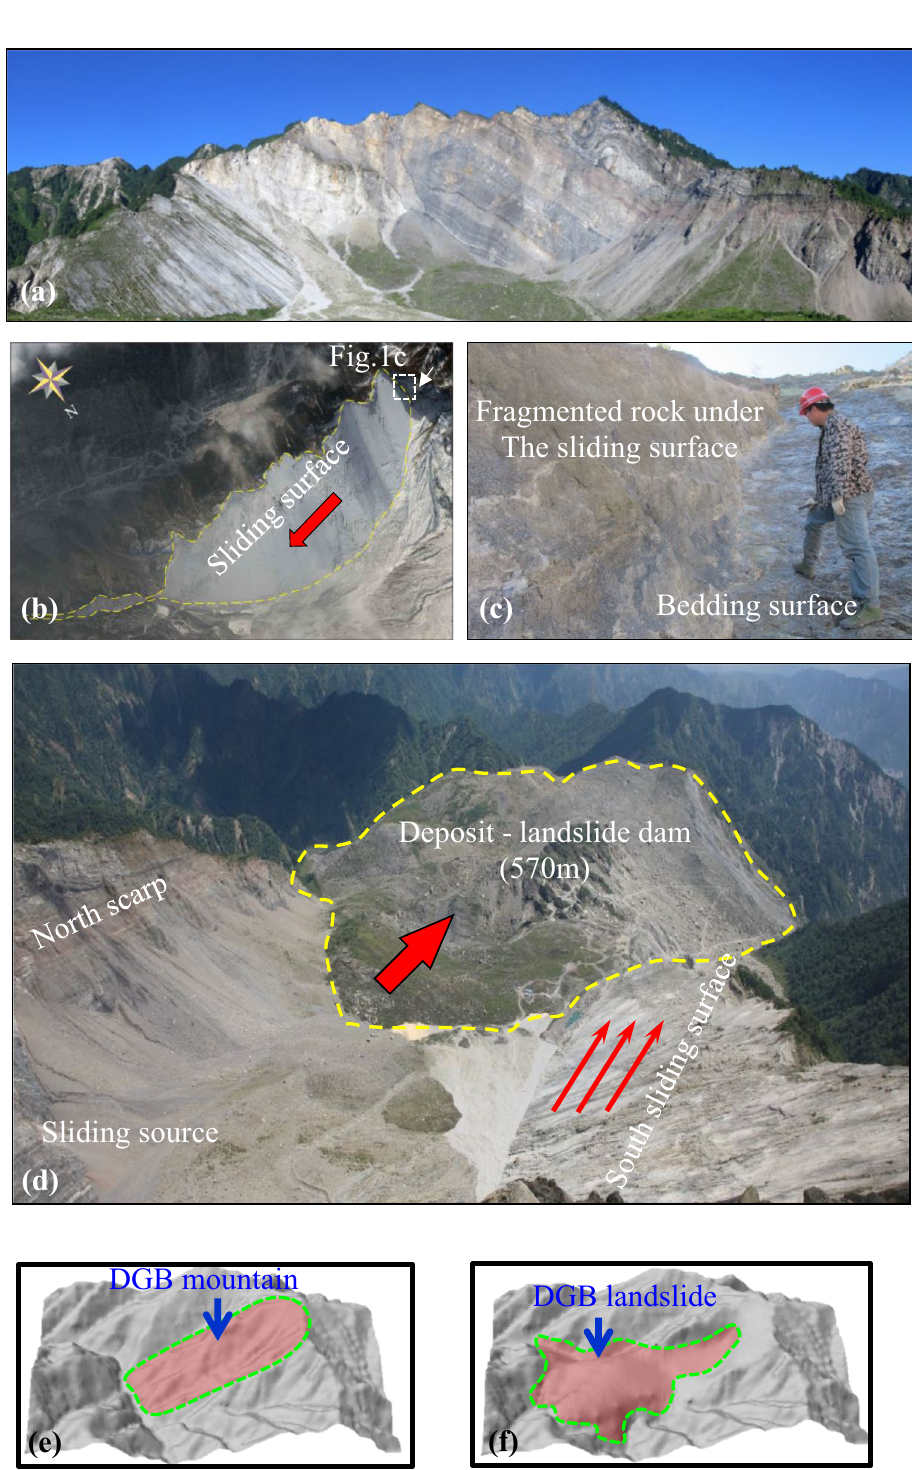
Figure 1. Geological setting of the sliding zone of DGB landslide ( a ) Overall view of DGB landslide; ( b ) South sliding surface of DGB landslide; ( c ) section showing the fault rock overlaying the bedding plane; ( d ) Top view of DGB landslide deposit area, the thick red arrow shows the direction of landslide movement, the thin red arrow shows the sliding direction of the south sliding surface. ( e ) Topography of the DGB mountain before landslide ( f ) Topography of DGB